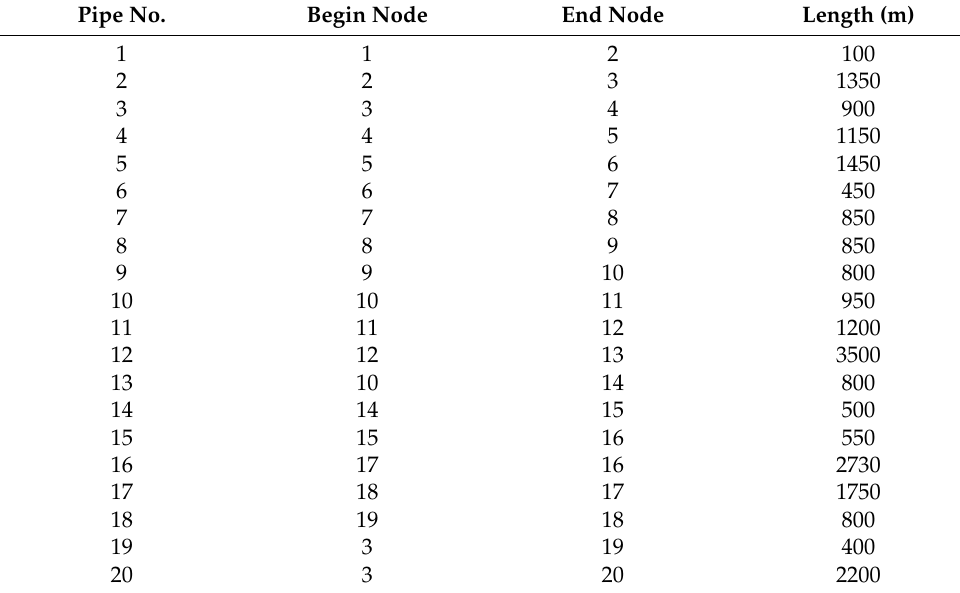
Table A4. Pipe data for the Hanoi